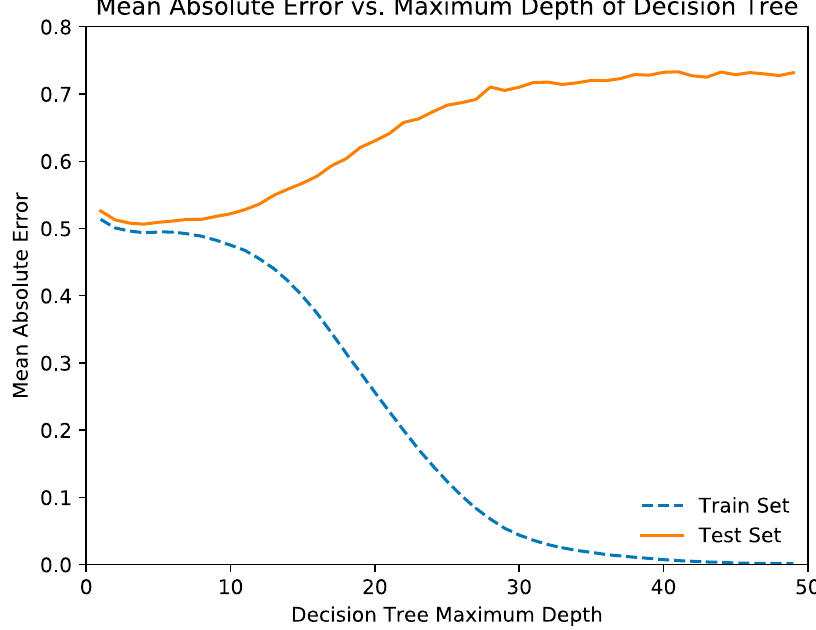
Figure 3. Illustrates the relationships of the decision tree depth with mean absolute error.